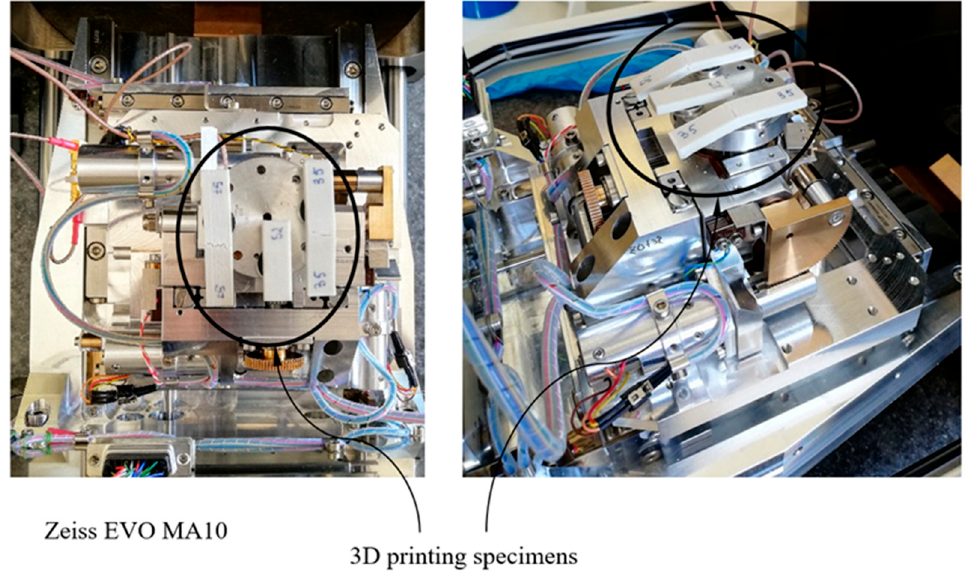
Figure 15. Set–up for the fracture surfaces analysis.